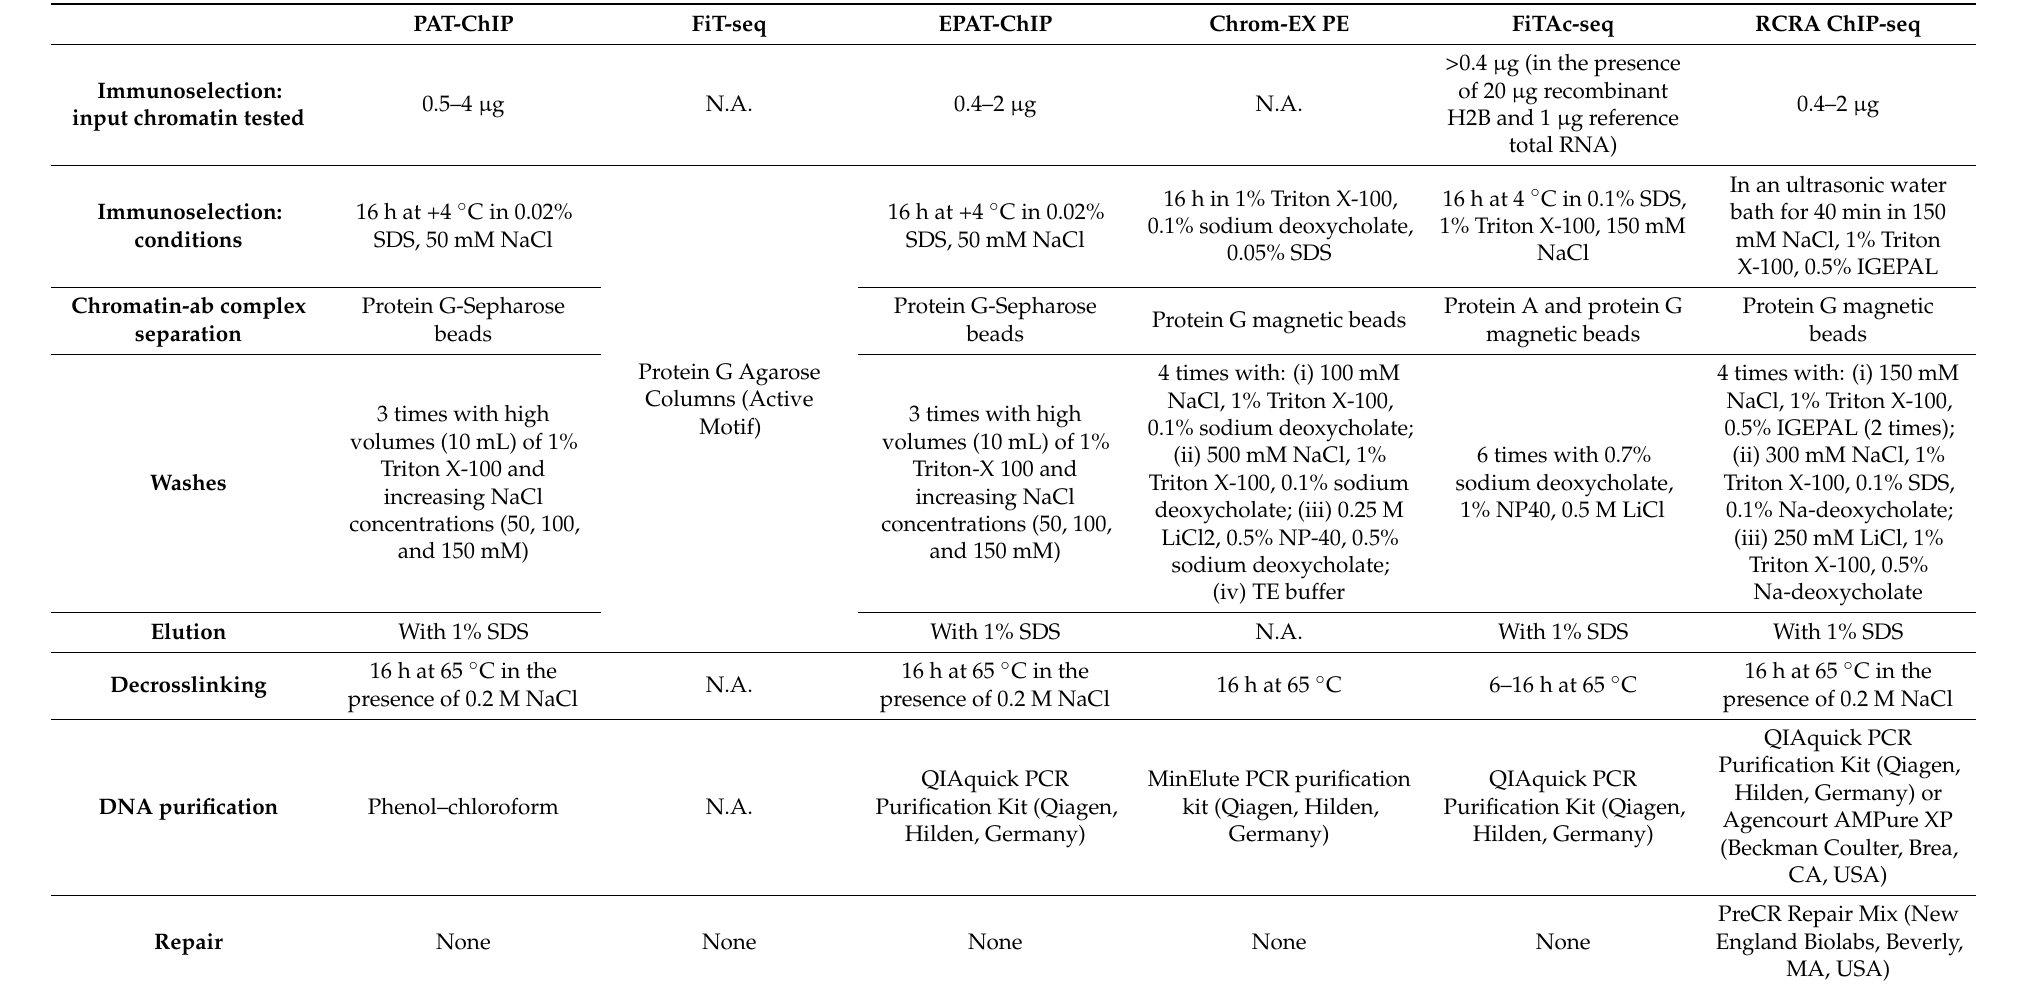
Table 4. Summary of the procedural steps used by the different FFPE-ChIP procedures for chromatin immunoselection and DNA